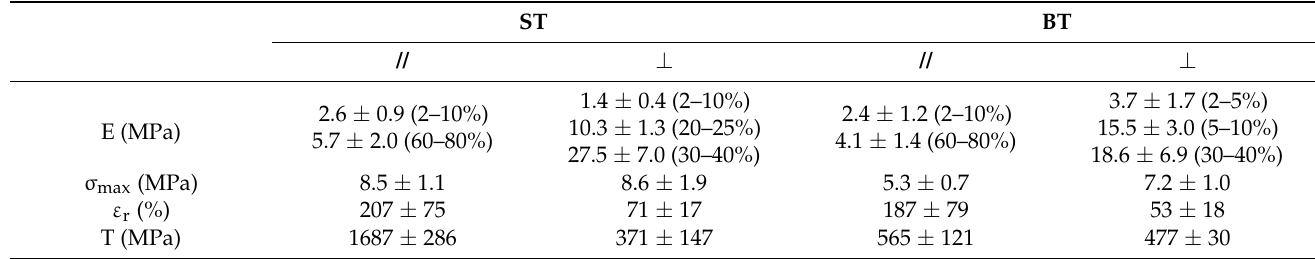
Table 4. Mechanical properties of ST and BT. Results are expressed as mean value ± SD. ST BT //